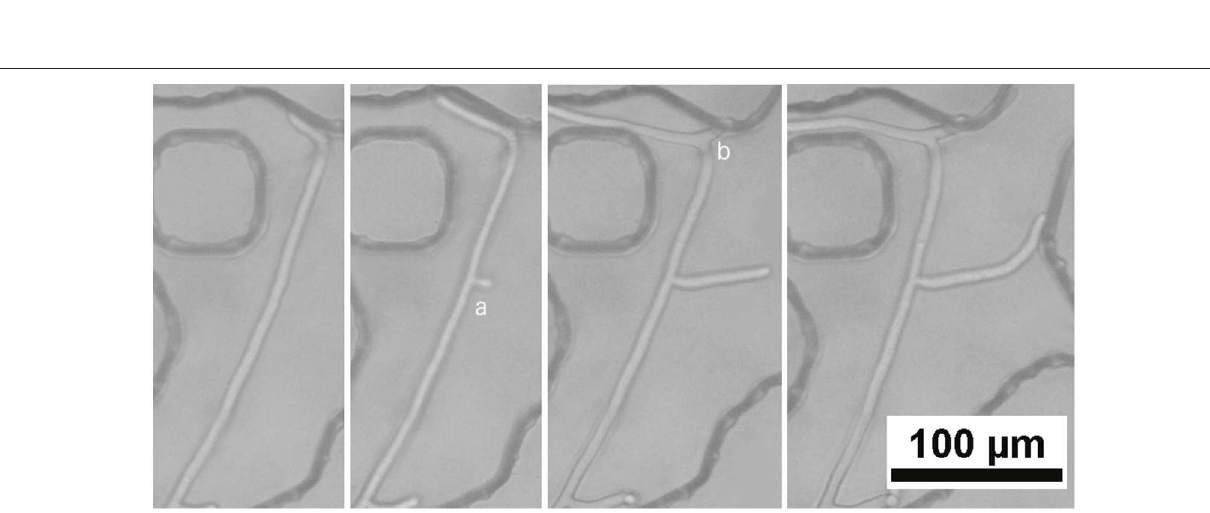
Frontiers in Environmental Science | www.frontiersin.org